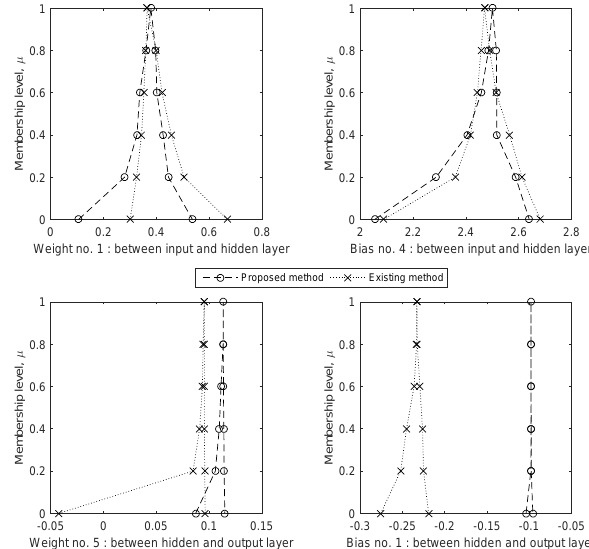
Figure 5. Sample plots of the produced membership functions for the weights and biases of the fuzzy neural network for both the pro- posed and existing